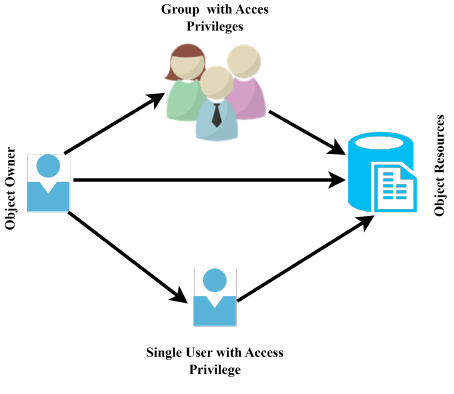
Figure 2. View of discretionary access control system